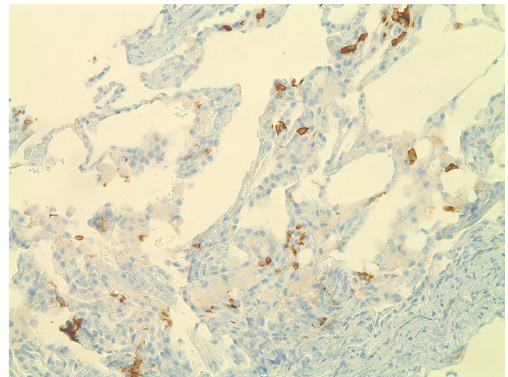
Figure 3: CD1a antigen